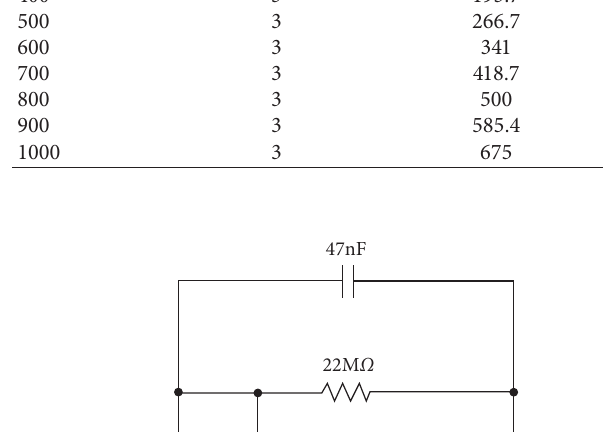
Figure 7: Instrumentation amplifier.